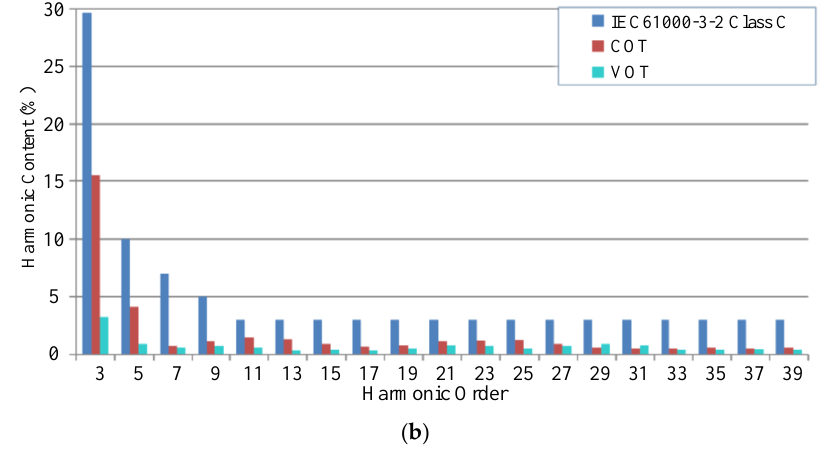
Figure 28. Input current harmonic content comparison data with rated 1 A output current. ( a ) 110 Vac input voltage; ( b ) 220 Vac input voltage.